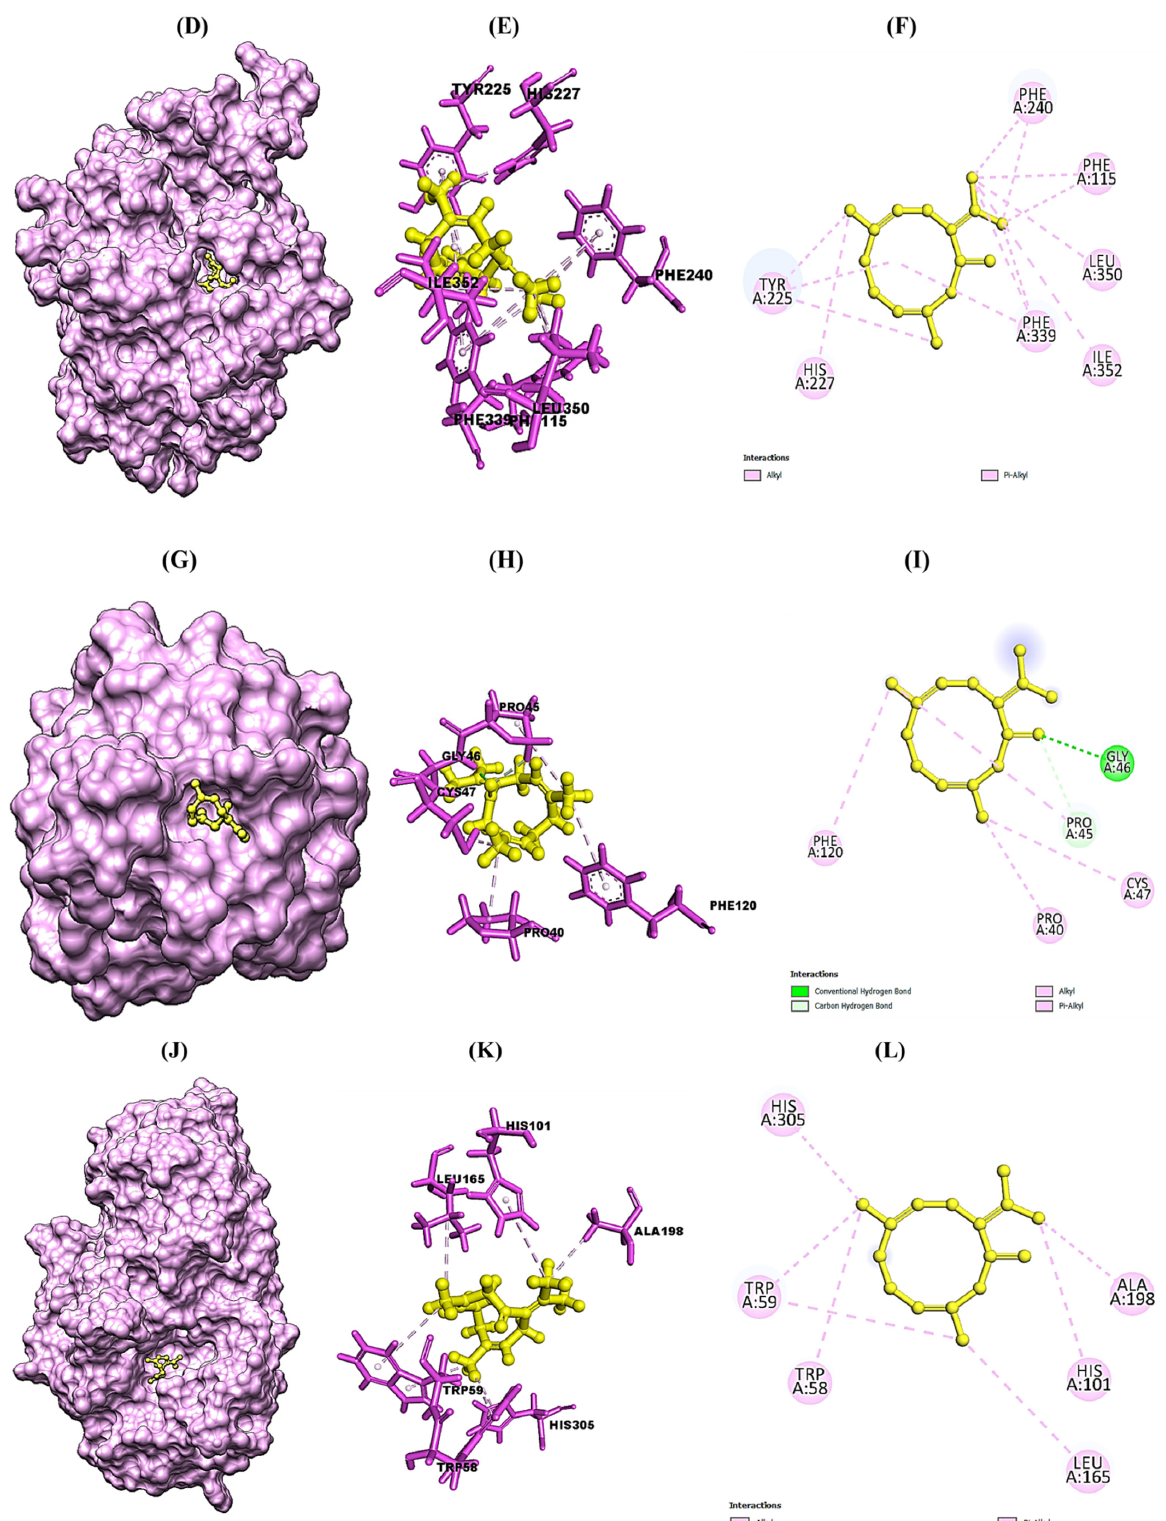
Figure 3. Structural representation of molecular docking analysis of 3,7-cyclodecadien-1-one, 3,7- dimethyl-10-(1-methylethylidene) with target proteins. ( A , D , G , J ) Binding of ligand inside 1EA1, 1IYL, IHD2, and IHNY proteins, respectively; ( B , E , H , K ) 3-D interactions of the ligand with the in- teracting amino acids of the selected 1EA1, 1IYL, IHD2, and IHNY proteins, respectively; ( C , F , I , L) 2-D interactions of the ligand with interacting amino acids of the selected 1EA1, 1IYL, IHD2, and IHNY proteins, respectively. Interactions were analyzed using Discovery Studio 2021 client soft- ware. Different colors indicate different types of interactions, namely, Van der Waals interactions in light green, conventional hydrogen bonds in green color, π –sigma in purple color, π – π –T shaped in dark pink color, and alkyl and π –alkyl bonds in light pink color. Table 4. Docking scores of phytocompounds and standard drugs with target protein receptors.